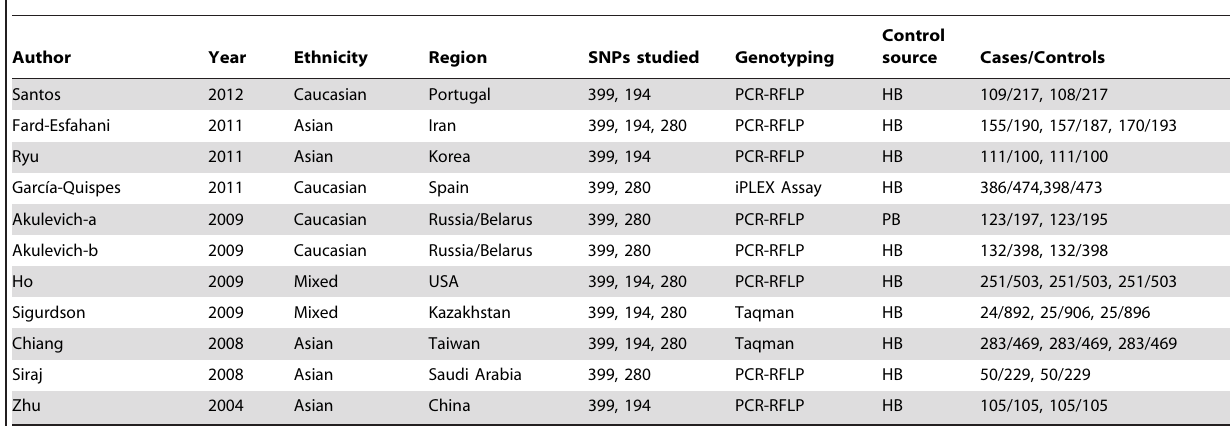
Table 1. Characteristics of studies included in the meta-analysis.